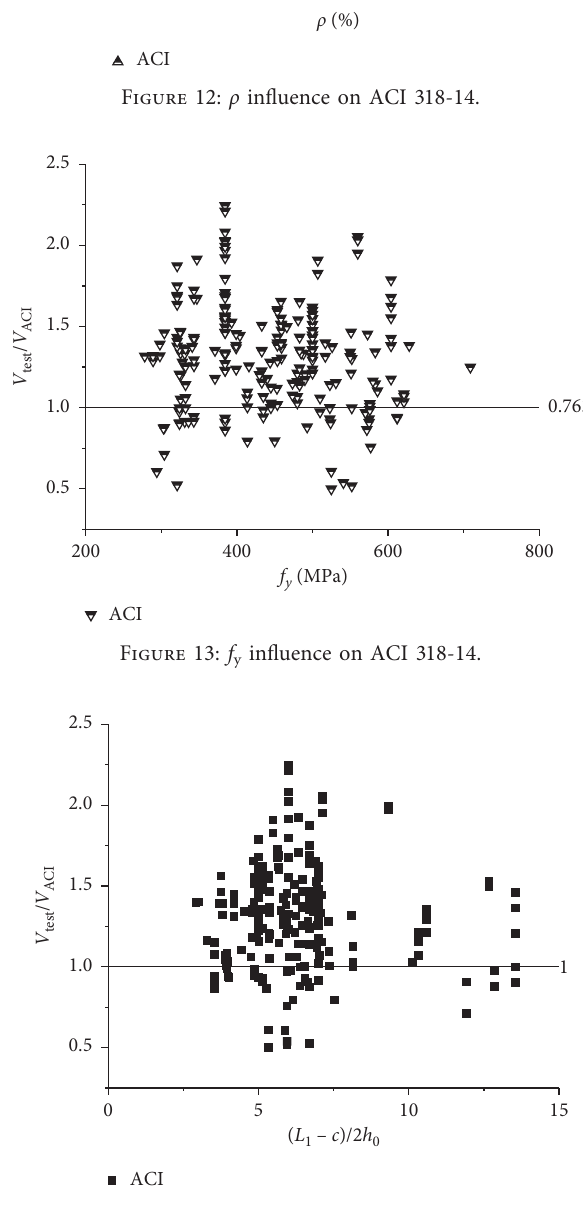
Figure 11: ρ influence on the BPNN model.